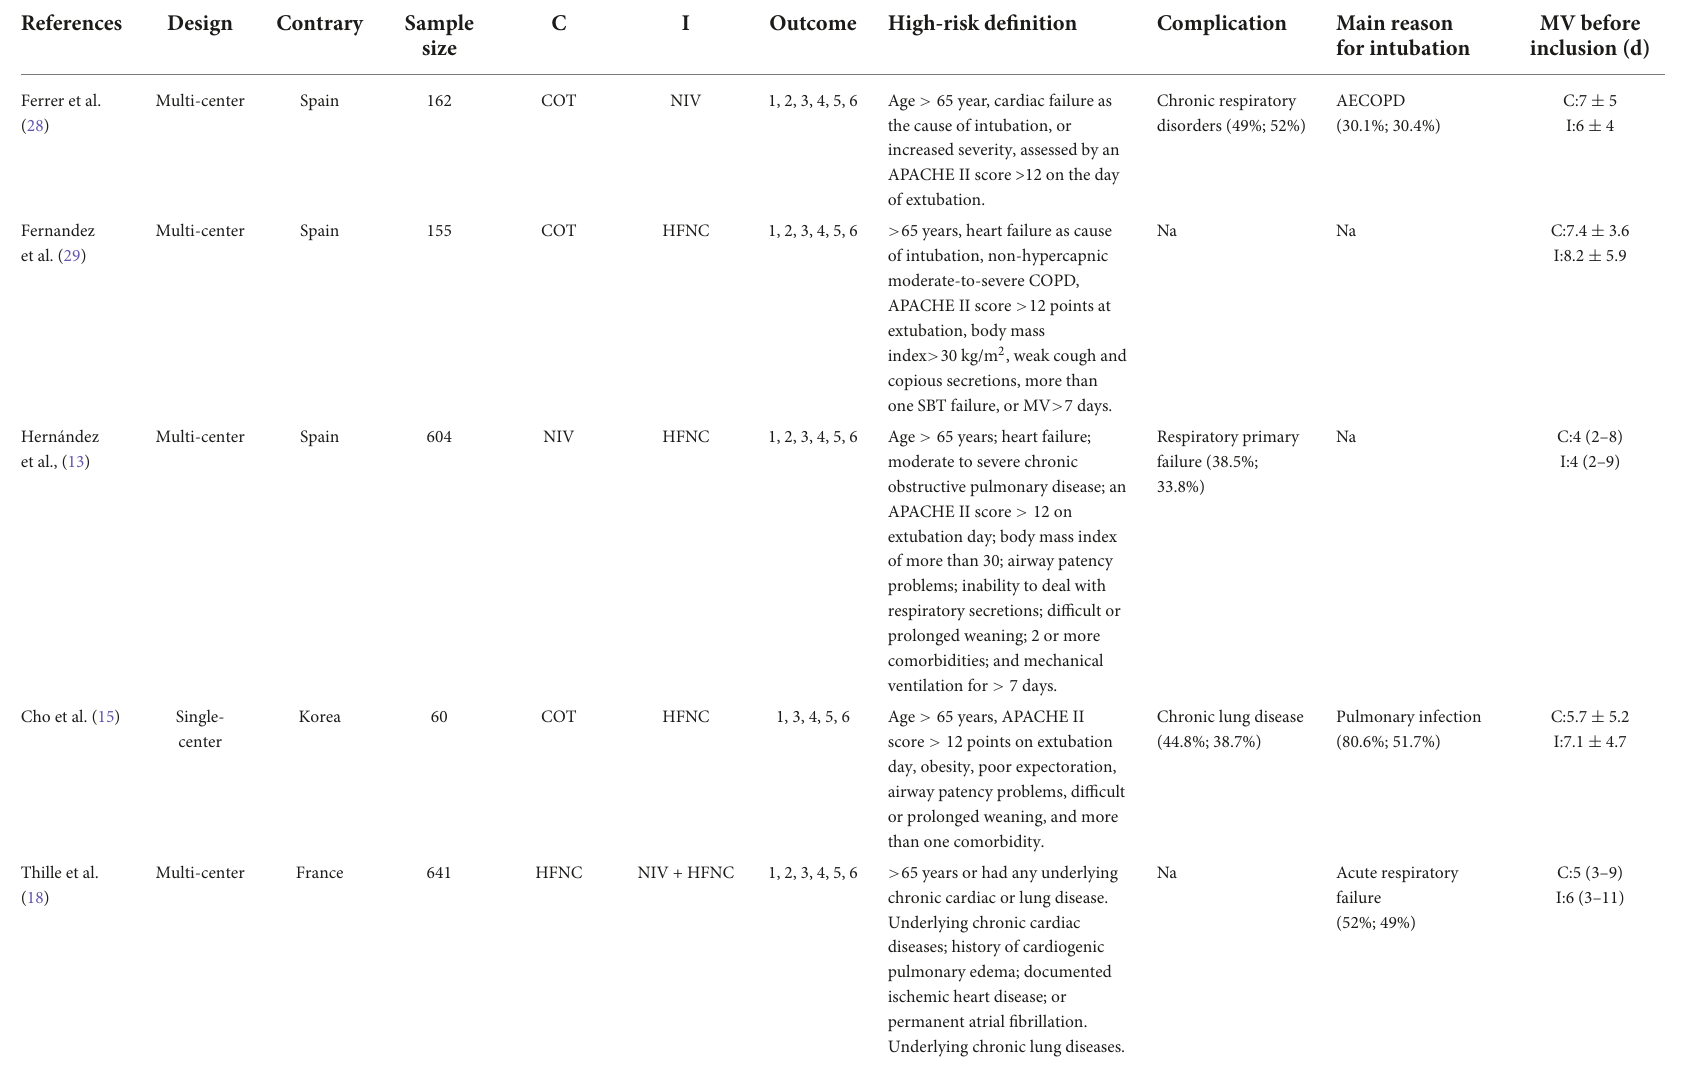
TABLE 1 Characteristics of the studies included in the network